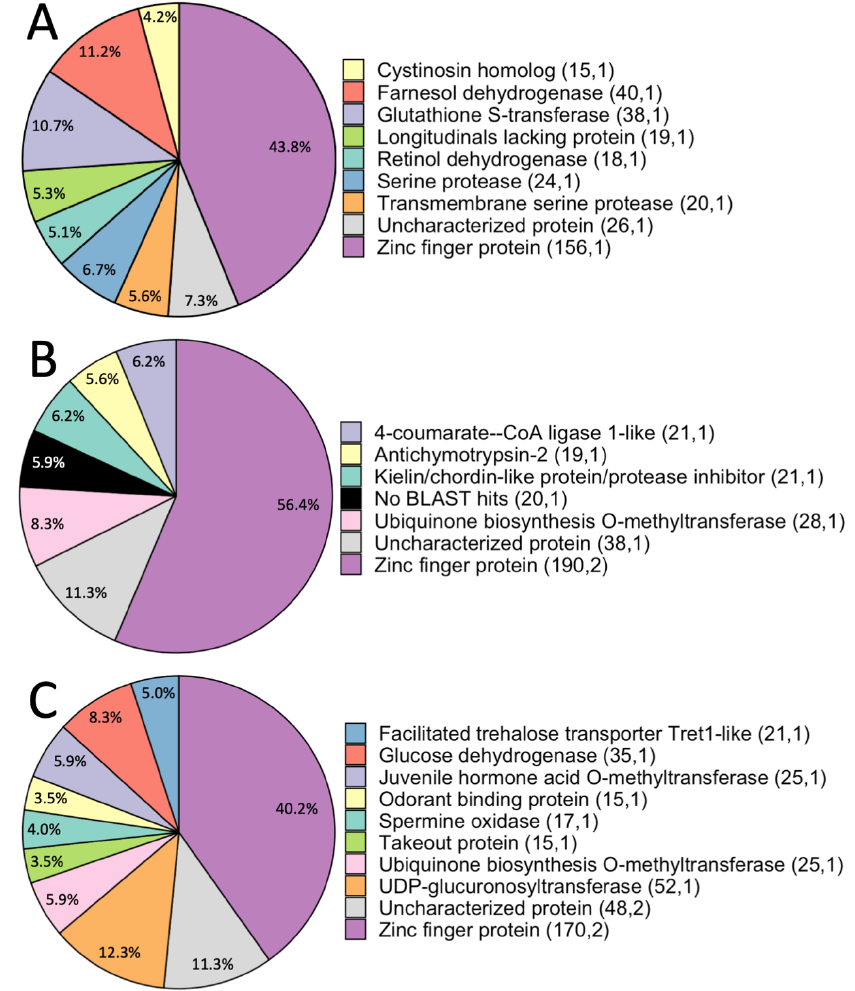
Figure 2. Homologs of genes under positive selection in each comparison identified by BLAST searches. Each color/slice represents the BLAST homolog for each gene family. Percentages represent the number of genes with that functional annotation divided by the total number of genes under positive selection. Parentheticals following each protein name represent (number of genes, number of gene families). ( A ) Photuris sp. and Photuris frontalis comparison. ( B ) Photuris frontalis and Photinus pyralis comparison. ( C ) Photuris sp. and Photinus pyralis comparison. Detailed results, including representation of sequences from each species in the comparison, can be found in supplemental Tables